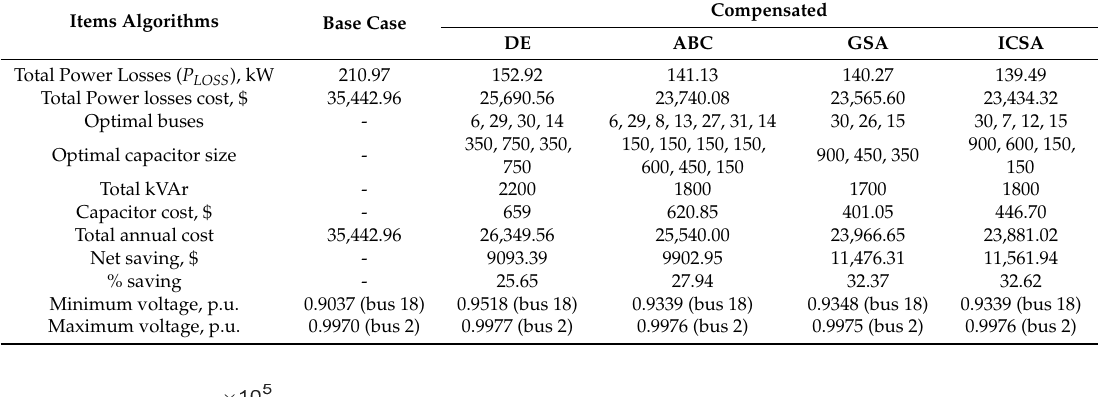
Table 11. Experimental results of 33-bus system.